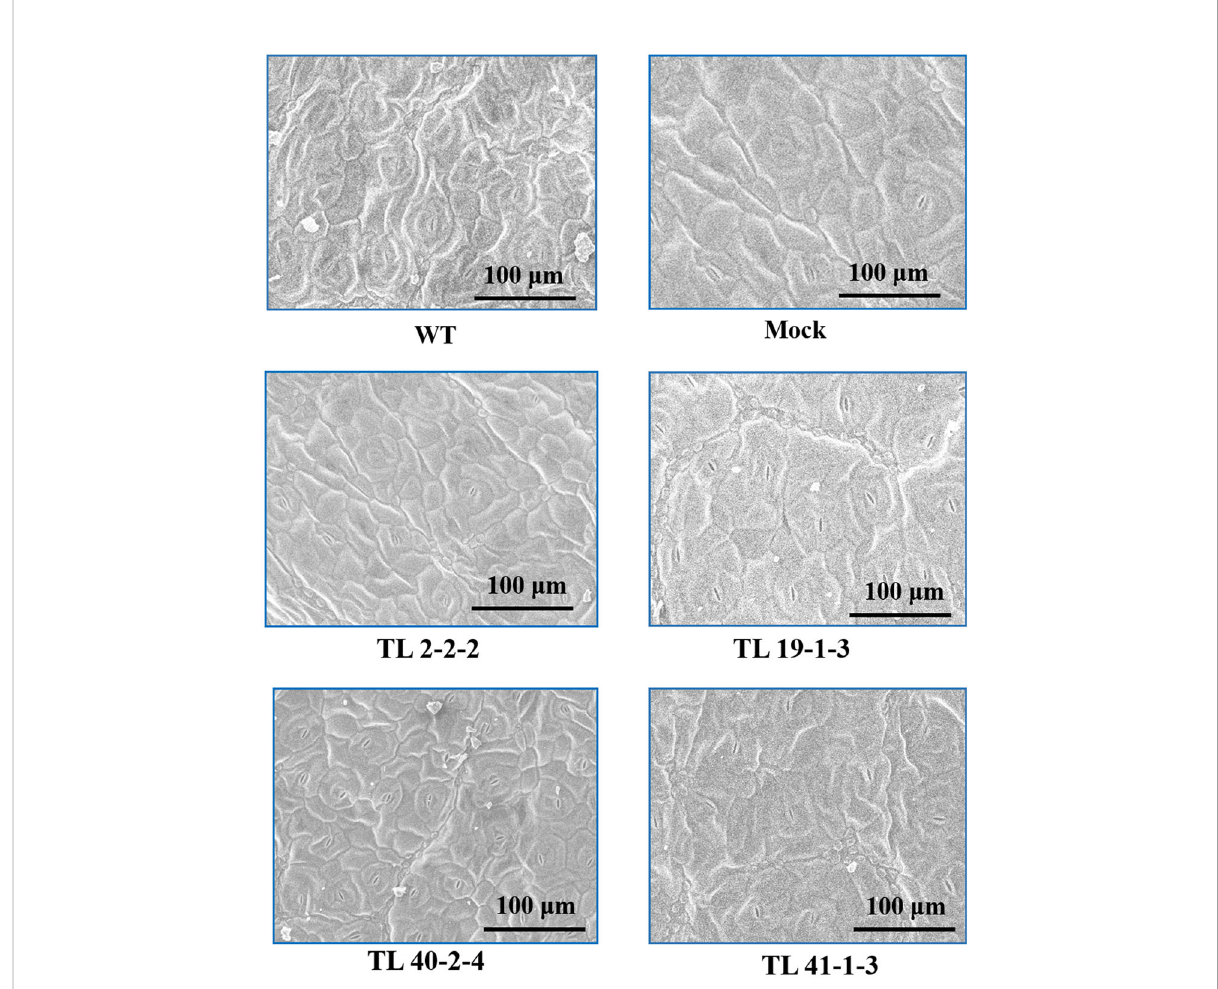
FIGURE 6 Scanning electron microscope (SEM) showing stomata number: The image depicting the variation in the stomata number on the leaf surface (adaxial surface) of wild type (WT), mock and multigene transgenic groundnut lines (TL 2-2-2, TL 19-1-3, TL 40-2-4 and TL 41-1-3) under drought stress. The SEM images were taken at 100 m m focal